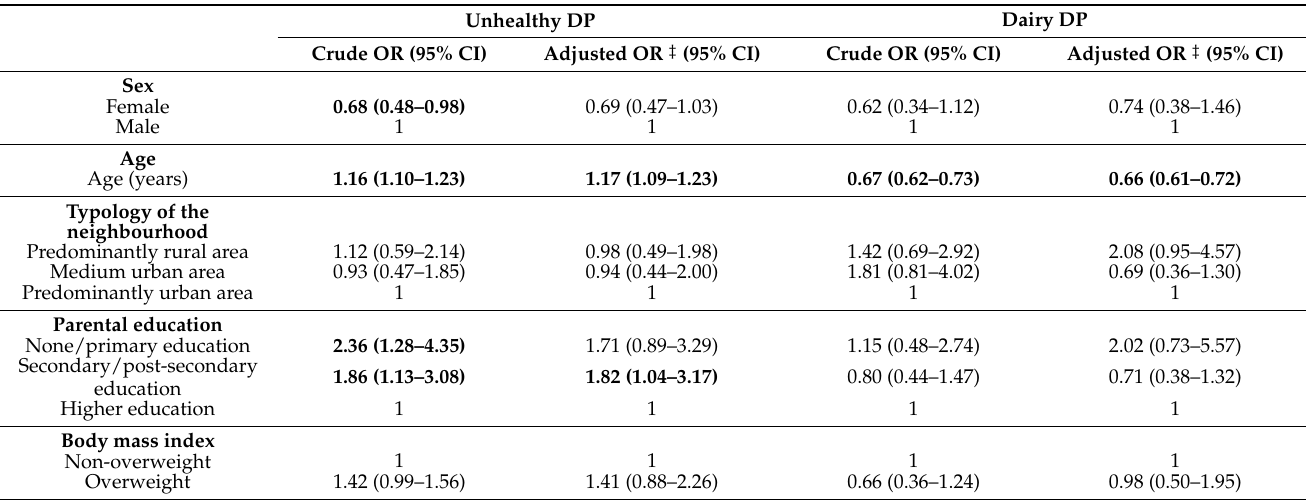
Table 3. Multinomial logistic regression analysis of the associations between sociodemographic and nutritional characteris- tics with dietary patterns among Portuguese population aged 3–17: The UPPER